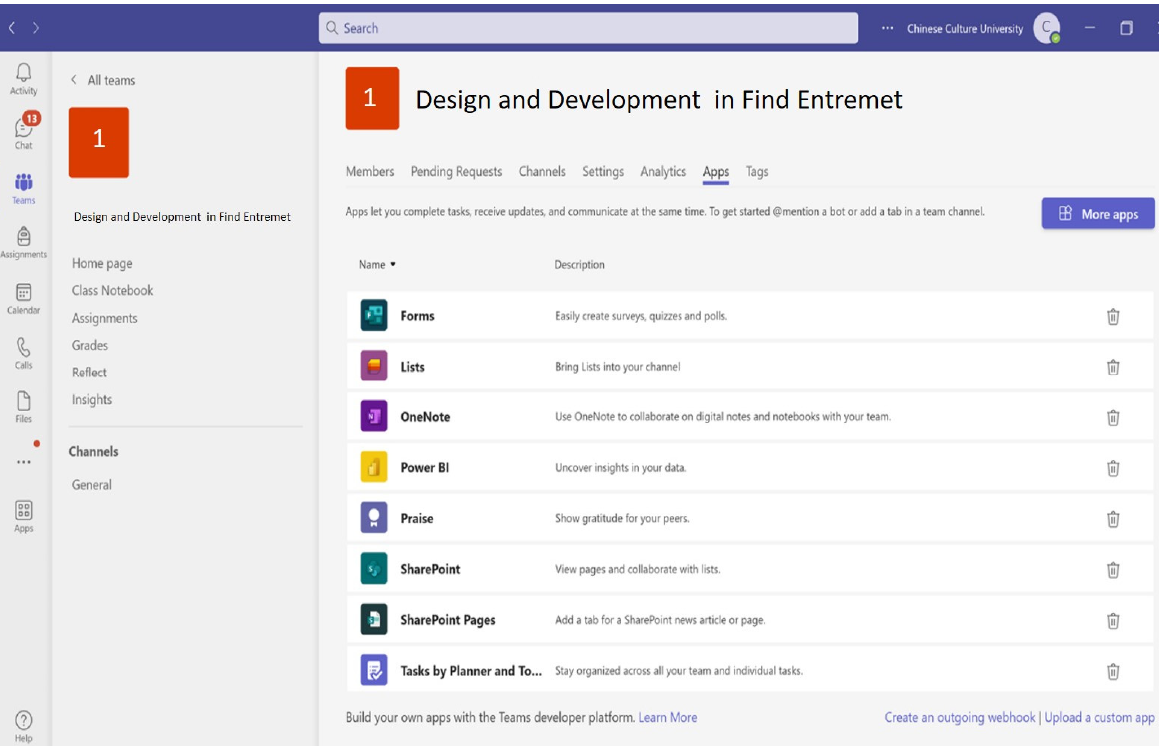
Figure 1. Microsoft Teams System.